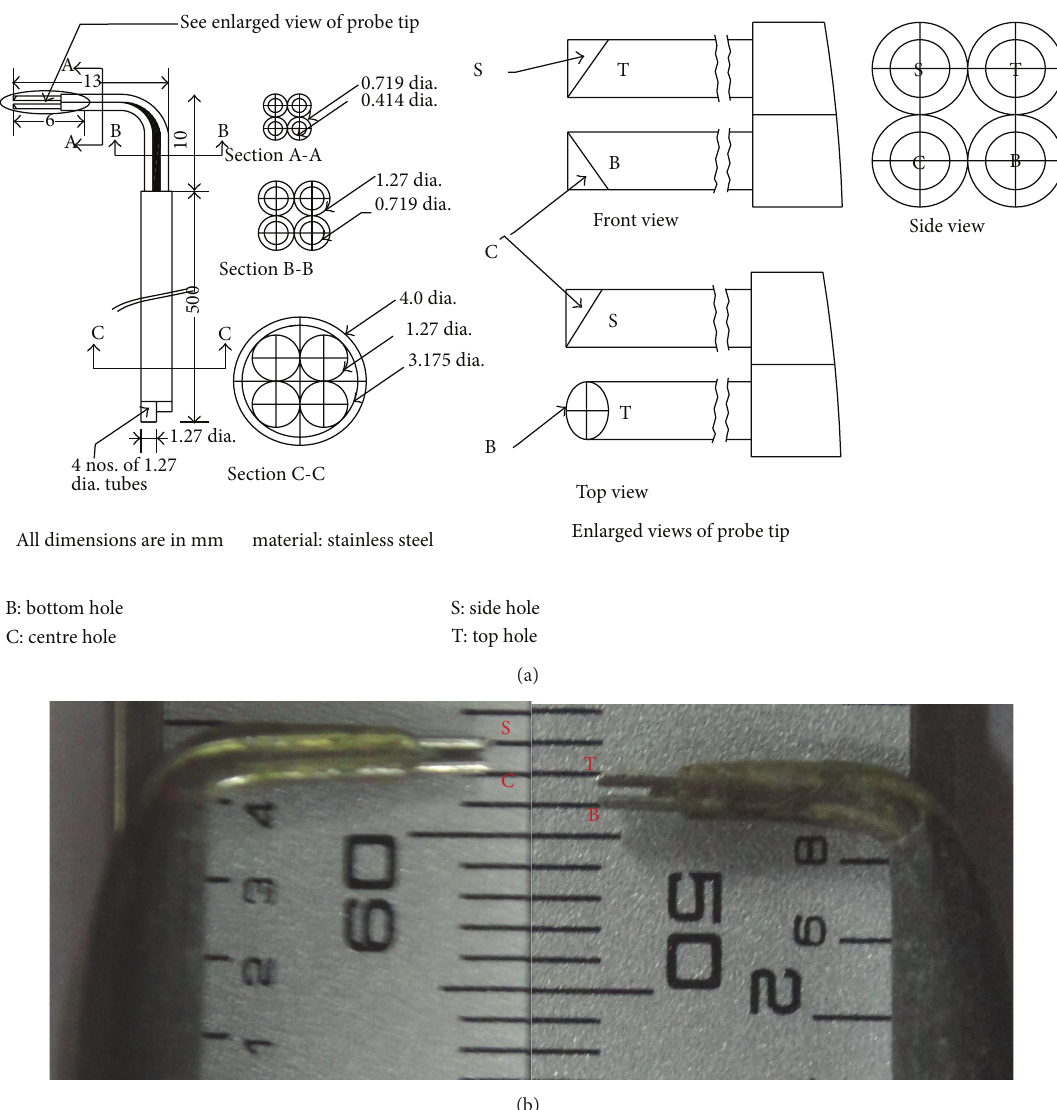
Figure 2: (a) AutoCAD drawing of probe. (b) Photo of probe